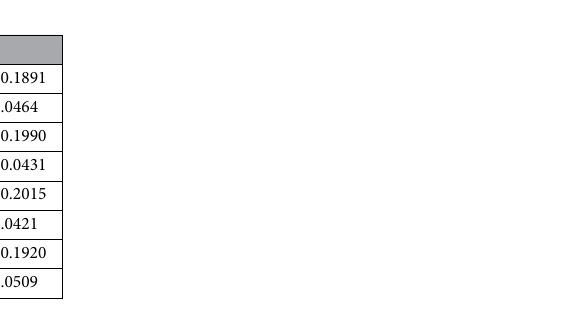
Table 2. Mean attenuation and transmission (± standard deviation) averaged over both experiments. All values are computed over all intensities along the projection line within the implant image in Fig. 1.